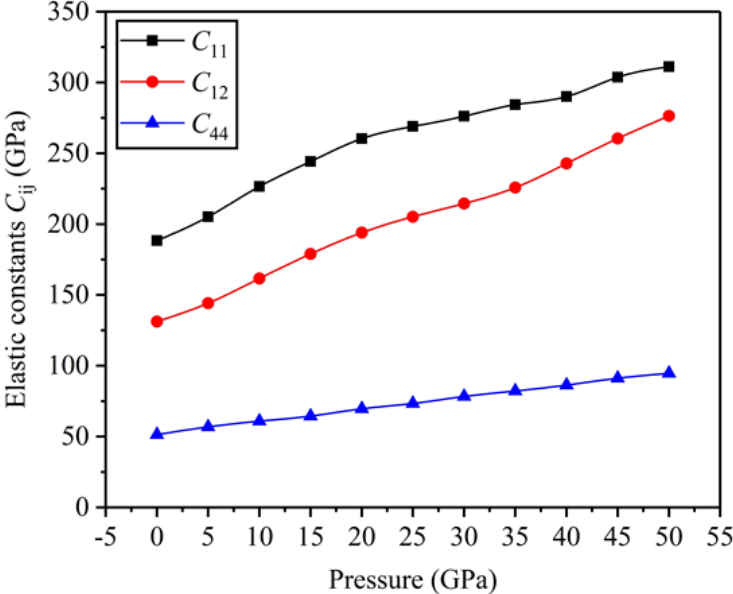
C under different pressures for the NiTi SMA. Figure 4. Variation curves of the elastic constants C ij under di ff erent pressures for the NiTi ij